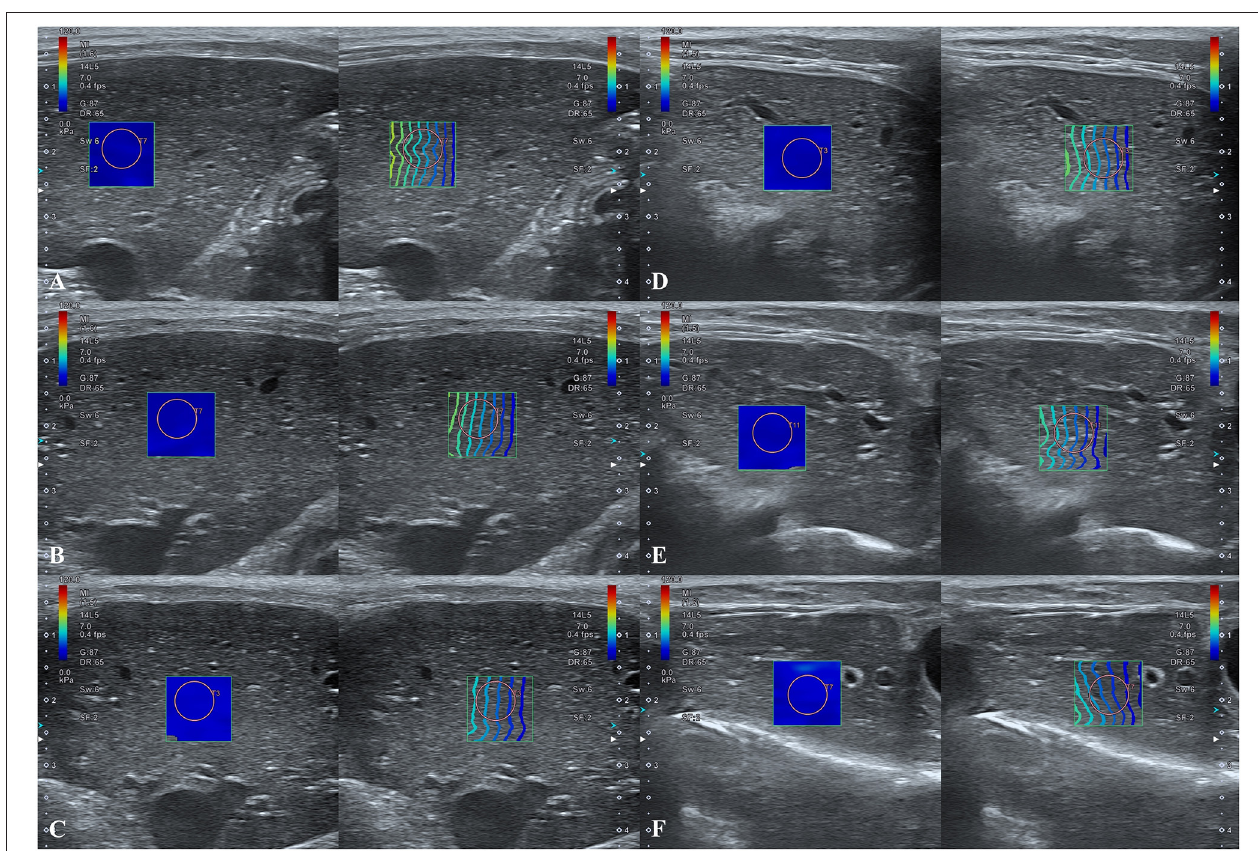
FIGURE 4 | Hepatic two-dimensional shear wave elastographic images according to breathing phases. (A–C) Intercostal approach at (A) forced-expiration 10 mL/kg, (B) end-expiration 0cm H 2 O, and (C) forced-inspiration 20cm H 2 O. (D–F) Subcostal approach at (D) forced-expiration 10 mL/kg, (E) end-expiration 0cm H 2 O, and (F) forced-inspiration 20cm H 2 O. Note that the diaphragmatic movements according to breathing phases in 2D-SWE images are greater for the subcostal approach than for the intercostal approach.